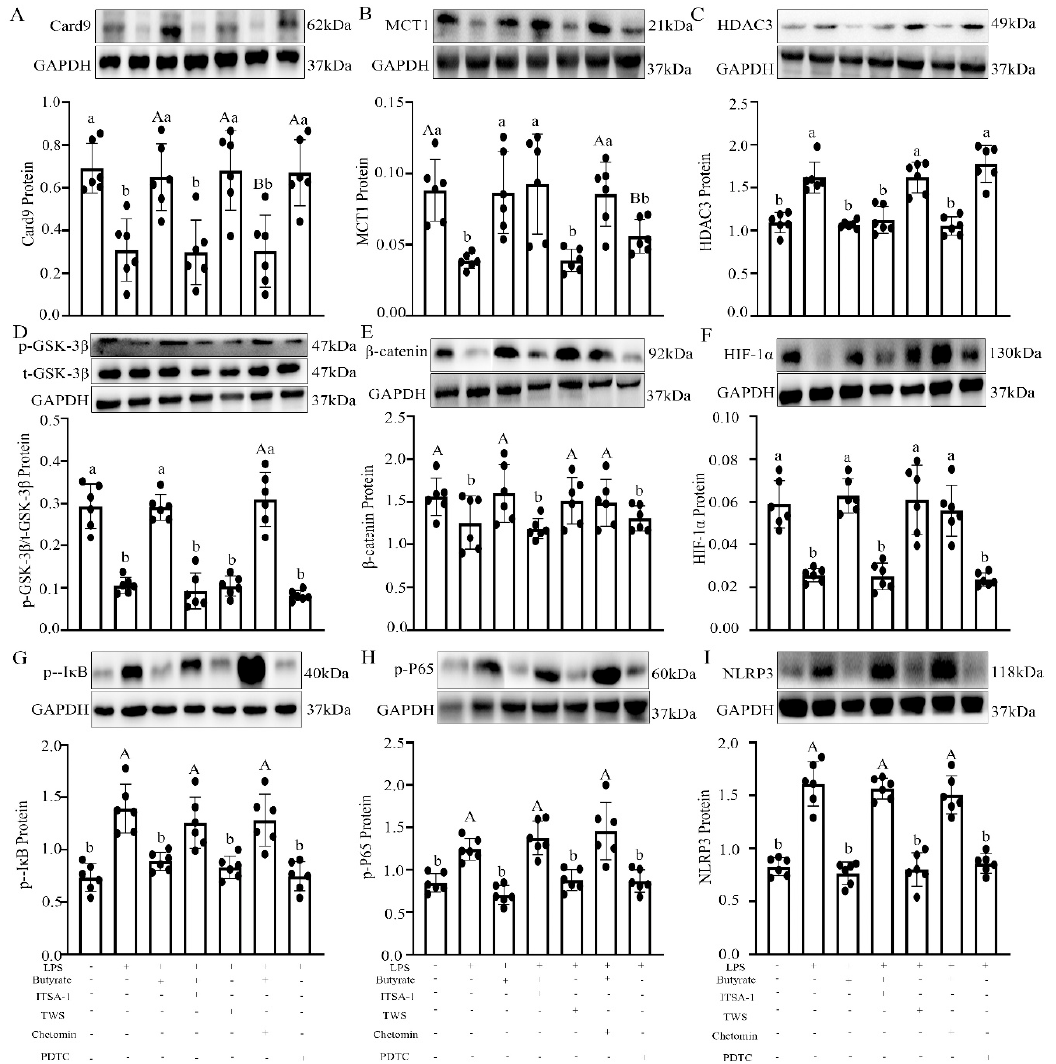
Figure 7. Improvement effect of butyrate on the relative levels of Card9 ( A ), MCT1 ( B ), HDAC3 ( C ), p-GSK-3 β ( D ), β -catenin ( E ), HIF-1 α ( F ), p-I κ B ( G ), p-P65 ( H ), and NLRP3 ( I ) in LPS-treated IECs. Chetomin, an antagonist of HIF-1 α ; PDTC, an antagonist of NF- κ B; ITSA-1, an agonist of HDAC3; TWS, an antagonist of GSK-3 β . Values are presented as the mean ± SE. Differences were assessed using ANOVA and are denoted as follows: different lowercase letters: p < 0.05; different uppercase letters: p < 0.01; same letter: p > 0.05.